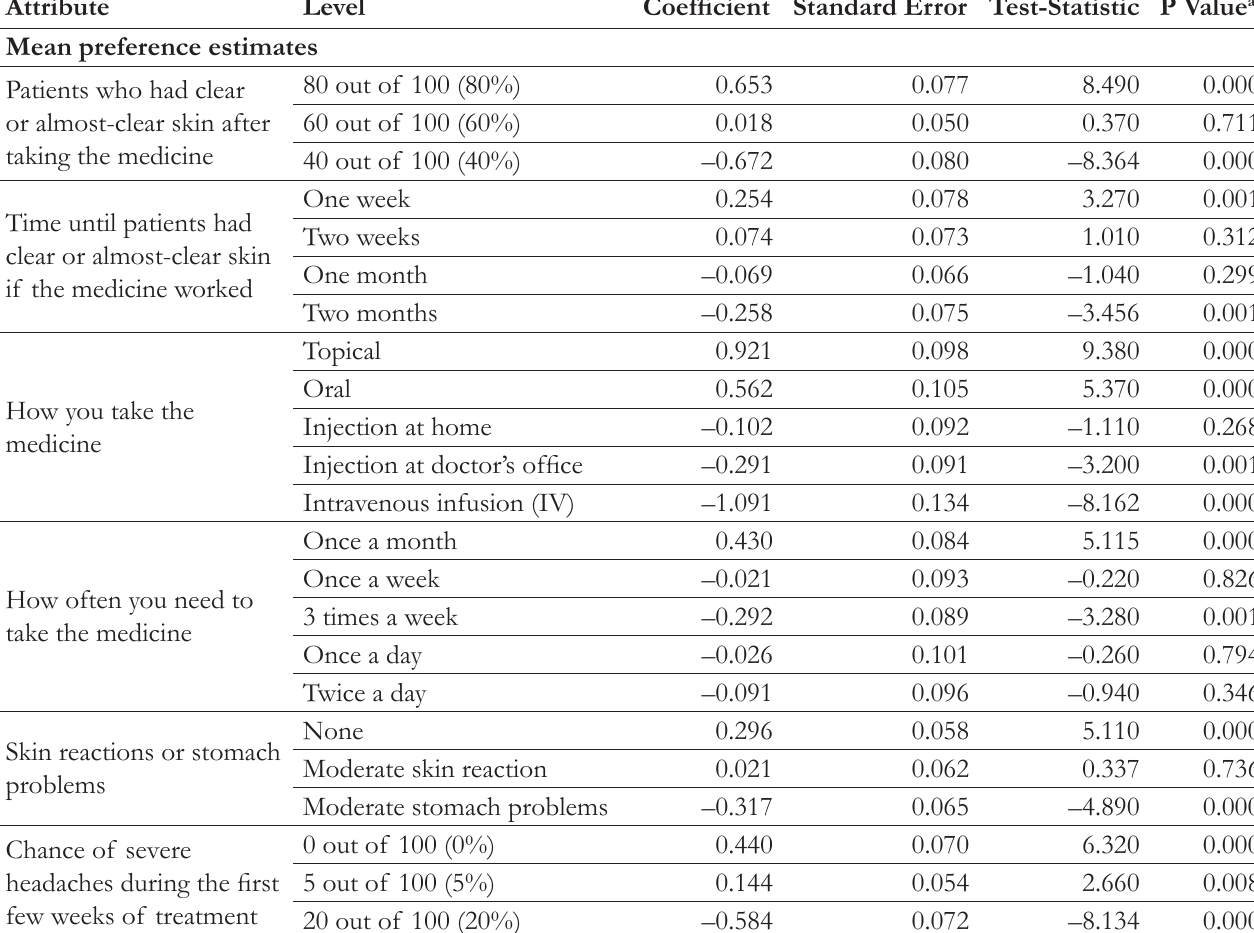
Table 4. Mean Preference Estimates and Standard Deviation of Preference Estimates Based on Treatment Choices for the Pooled Sample (N =